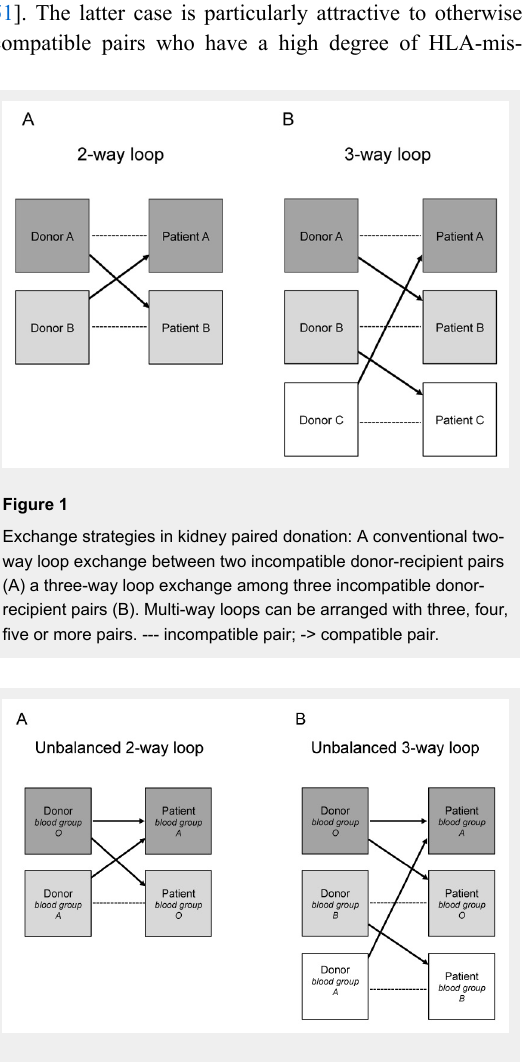
Exchange strategies in kidney paired donation. Unbalanced n-way loop exchanges between one compatible and one incompatible donor-recipient pairs (A) or one compatible and two incompatible donor-recipient pairs (B). --- incompatible pair; -> compatible